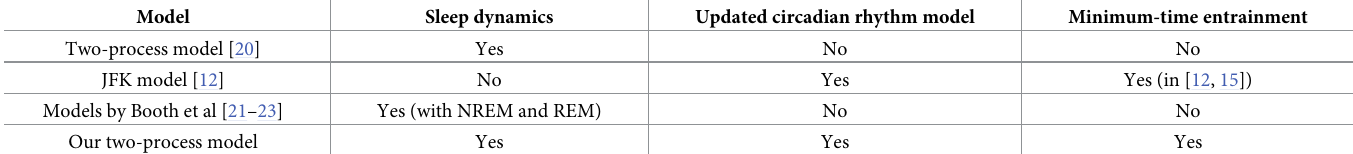
Table 1. Modeling